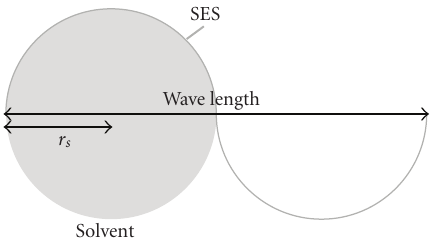
Figure 3: Minimal wavelength allowed on the SES. It corresponds to four times the solvent radius r s and determines the cuto ff frequency for the filtering.